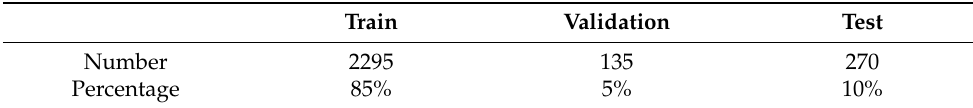
Table 2. Division of the dataset.